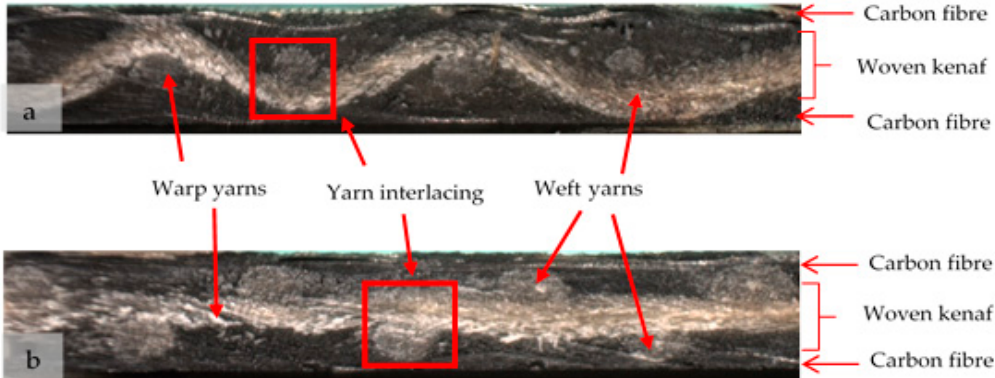
Figure 5. Cross section view of ( a ) warp direction and ( b ) weft view of laminated woven composite from plain fabric under optical microscope.